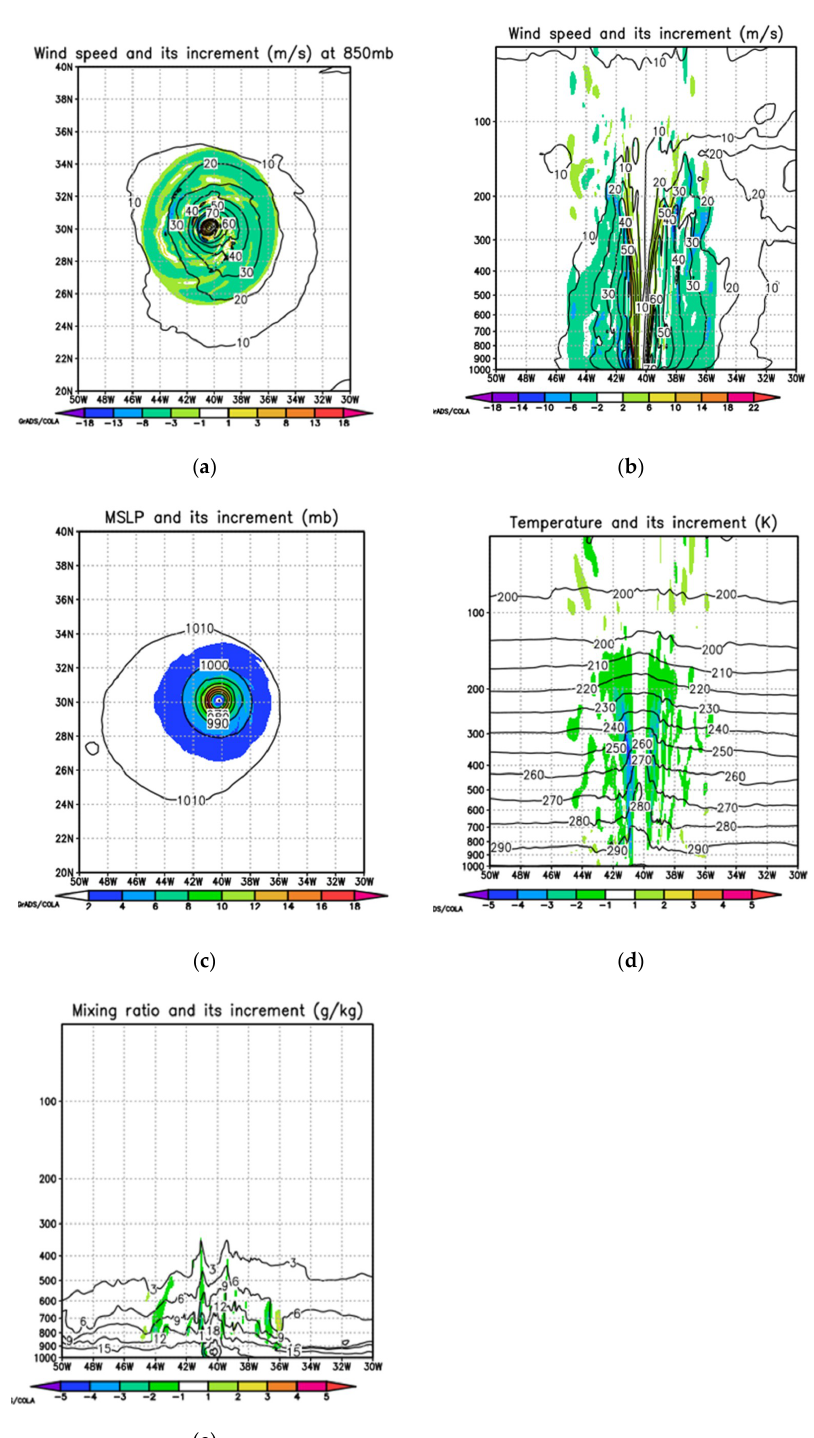
Figure 2. ( a – e ) The background fields and their increments after storm size corrections. ( a ) The background horizontal wind speed (m / s) (contour) and its initialization increment (m / s) (shaded) at 850 mb; ( b ) vertical cross-section of the background horizontal wind speed (m / s) (contour) and its increment (m / s) (shaded) at the latitude 30 ◦ N (storm center); ( c ) mean sea-level pressure (mb) (contour) and its increment (mb) (shaded); ( d ) vertical cross-section of the background temperature (K) (contour) and its increment (K) (shaded) at the latitude 30 ◦ N; ( e ) vertical cross-section of the background mixing ratio (g / kg) (contour) and its increment (g / kg) (shaded) at the latitude 30 ◦